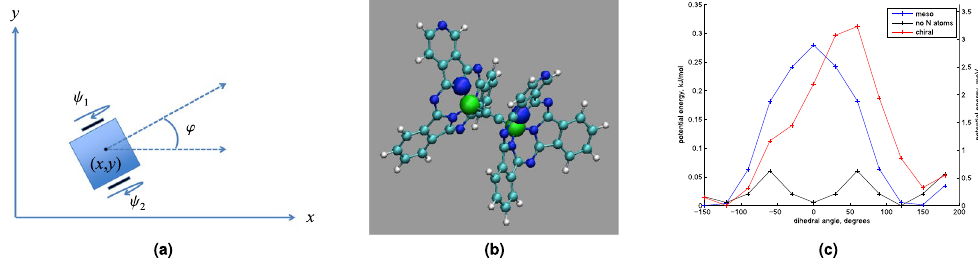
Figure 1. ( a ) Classical model of a two-wheeled carriage. ( b ) Model of the meso isomer of the double-wheeled molecule from 5 . Green, blue, cyan, and white atoms are boron, nitrogen, carbon, and hydrogen atoms respectively. The large spheres are the four atoms used to define the dihedral angle θ ψ ψ = − measure internal rotation. ( c ) Relative potential energy as a function of intramolecular rotation, as measured by θ d . For each curve, the minimum energy is set to zero. Curves are shown for the meso and chiral isomers as well as a model in which N tags have been replaced by CH